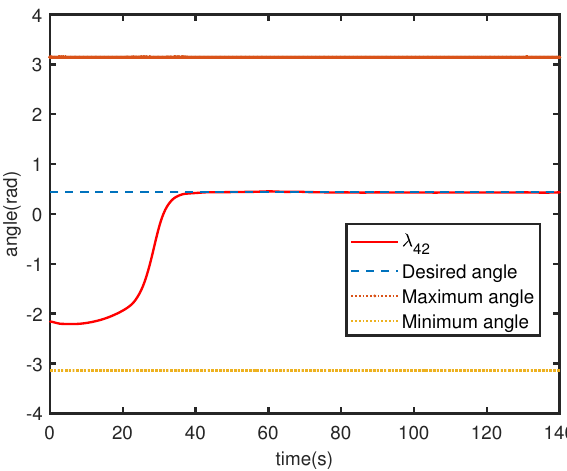
Figure 8. Angle between USV 2 and USV 4.